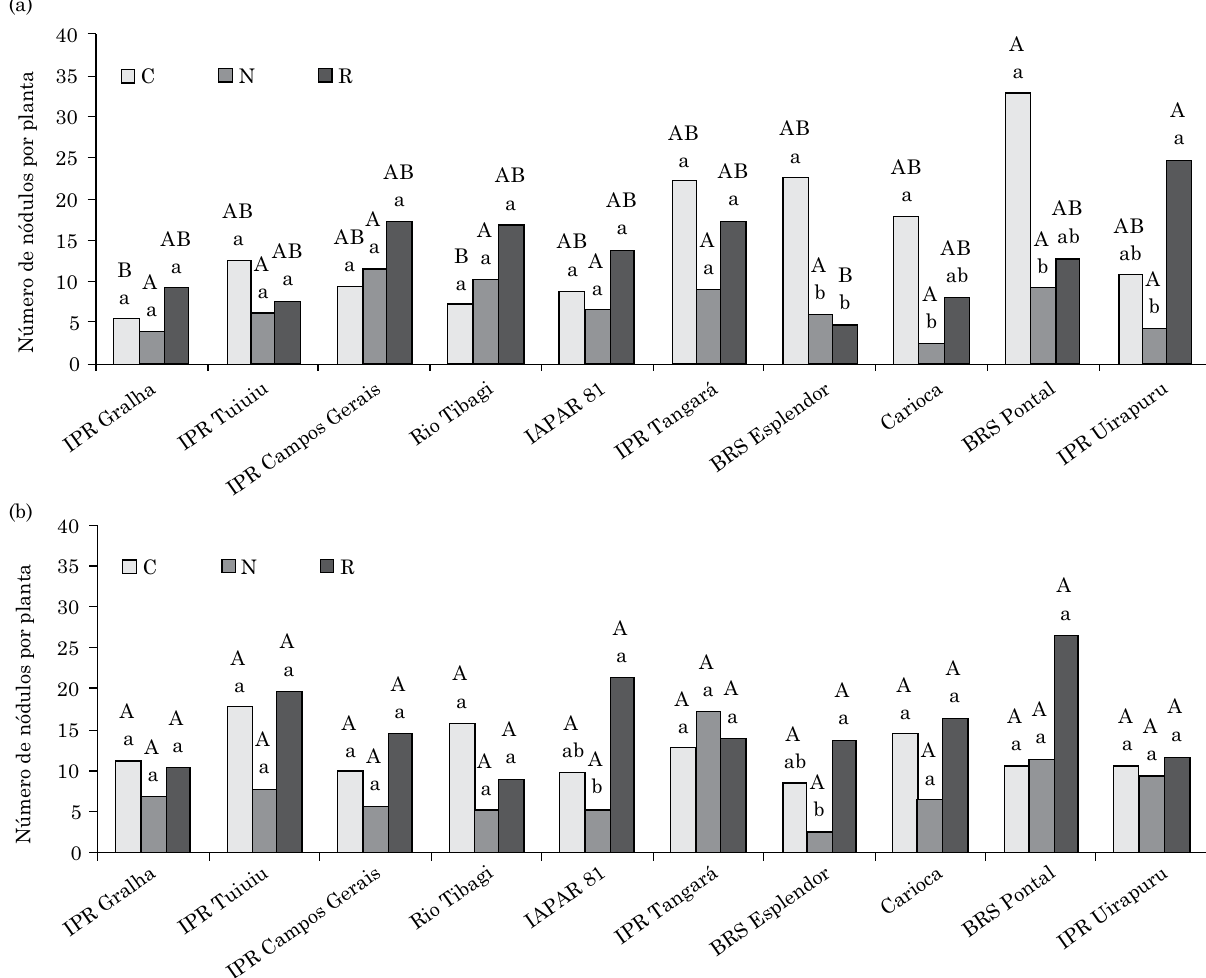
Figura 2. números de nódulos em cultivares de feijoeiro na safra da seca-2012 (a) e das águas-2012/2013 (b) cultivados sem n e sem inoculação de sementes (C); com adubação nitrogenada (n) e com a inoculação das sementes com Rhizobium freirei (r). letras iguais, maiúsculas, entre cultivares no mesmo tratamento em nutrição nitrogenada, e minúsculas, entre tratamentos em nutrições nitrogenadas para a mesma cultivar, indicam ausência de diferença significativa pelo teste de Tukey a 5 %. Coeficientes de variação, safra da seca-2012: 35,9 % e safra das águas: 38,8